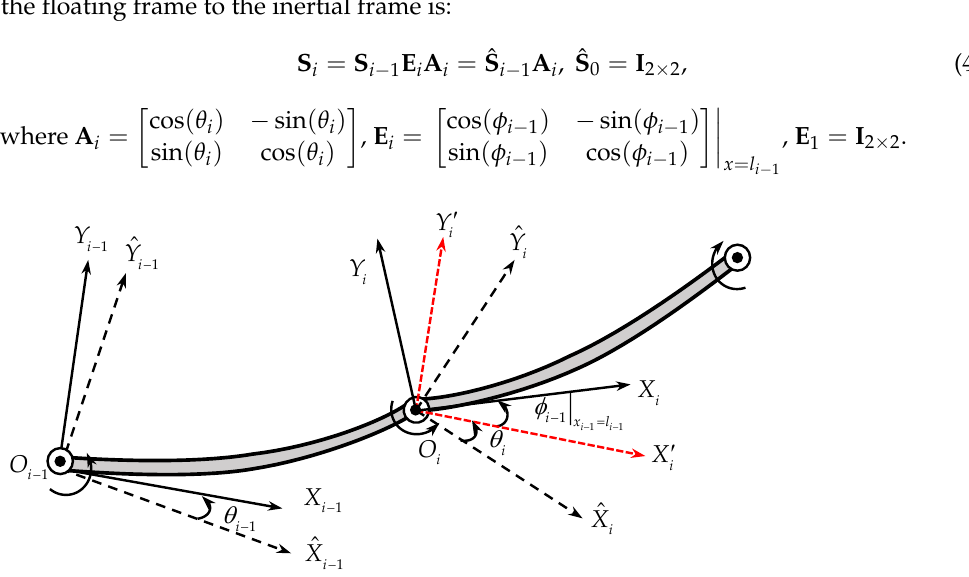
Figure 3. Schematic of two adjacent links in a manipulator system.